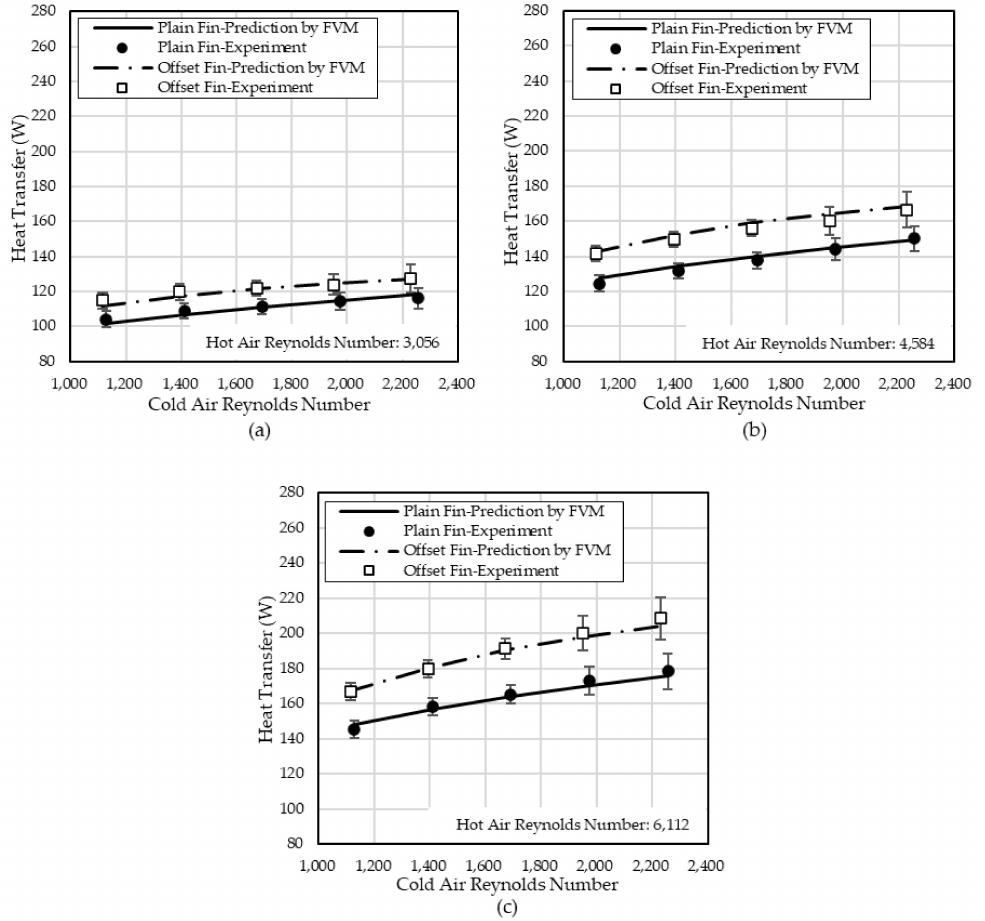
Figure 6. Experimental and numerical comparison of heat transfer in the plate-fin heat exchanger at 3.5 mm of fin pitches as a function of cold airflow rate, ( a ) Re = 3056 for the hot airflow rate; ( b ) Re = 4584; ( c ) Re =